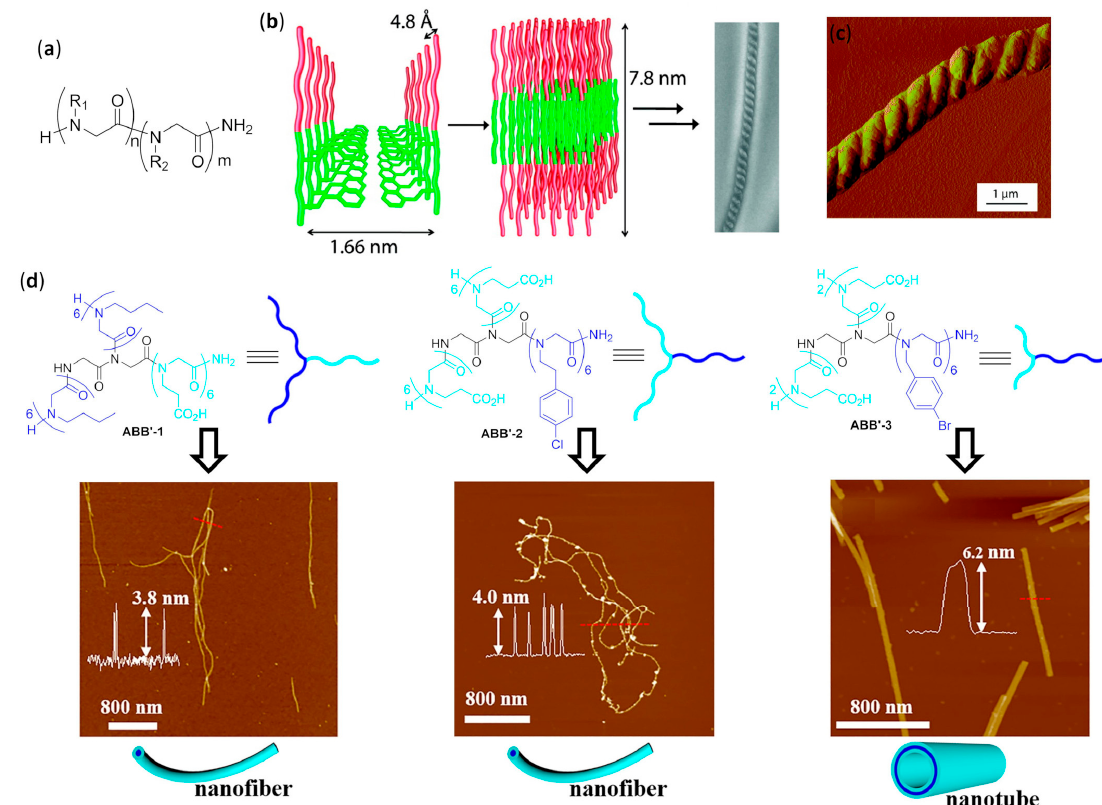
Figure 23. ( a ) General structure of amphiphilic diblock copolypeptoids (R 1 = lipophilic group, R 2 = hydrophilic group) (Refs. [58–73,258]); ( b ) Proposed scheme for the formation of fibers of Npe 15 Nce 15 in aqueous environment (green: hydrophobic block; red: hydrophilic block): the initially formed monolayers generate bilayers by interdigitating the hydrophobic fully extended chains, which in turn form the right-handed superhelices after further (not characterized) steps (reprinted with permission from Ref. [258]); ( c ) SEM image of a superhelix of Npe 15 Nce 15 (reprinted with permission from Ref. [258]); ( d ) Chemical structures (hydrophilic chains in cyan and hydrophobic chains in blue; common centric star pivot in black), cartoon representations and AFM images with selected height profiles of hierarchical structures from aqueous self-assembly of TASS peptoids: ABB’-1 (left); ABB’-2 (middle); ABB’-3 (right) (adapted with permission from Ref. [259]).